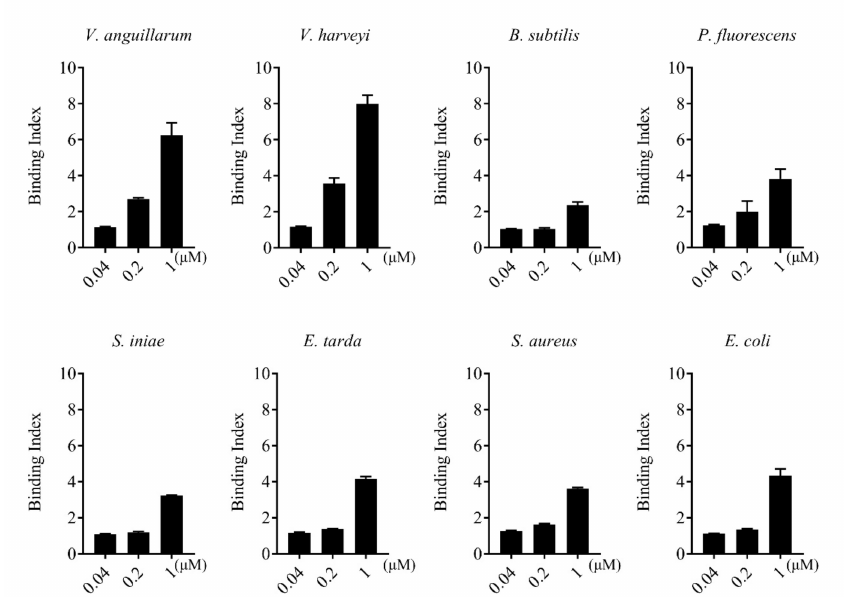
Figure 5. Bacteria binding ability of rCsGal-8. The binding of different concentrations of rCsGal-8 to different bacteria ( Vibrio anguillarum , Vibrio harveyi , Edwardsiella tarda , Streptococcus iniae , Pseudomonas fluorescens , Staphylococcus aureus , Escherichia coli , and Bacillus subtilis ) was determined by ELISA with PBS as a control. Values are the means of three experimental replicates and shown as means ± S.D.